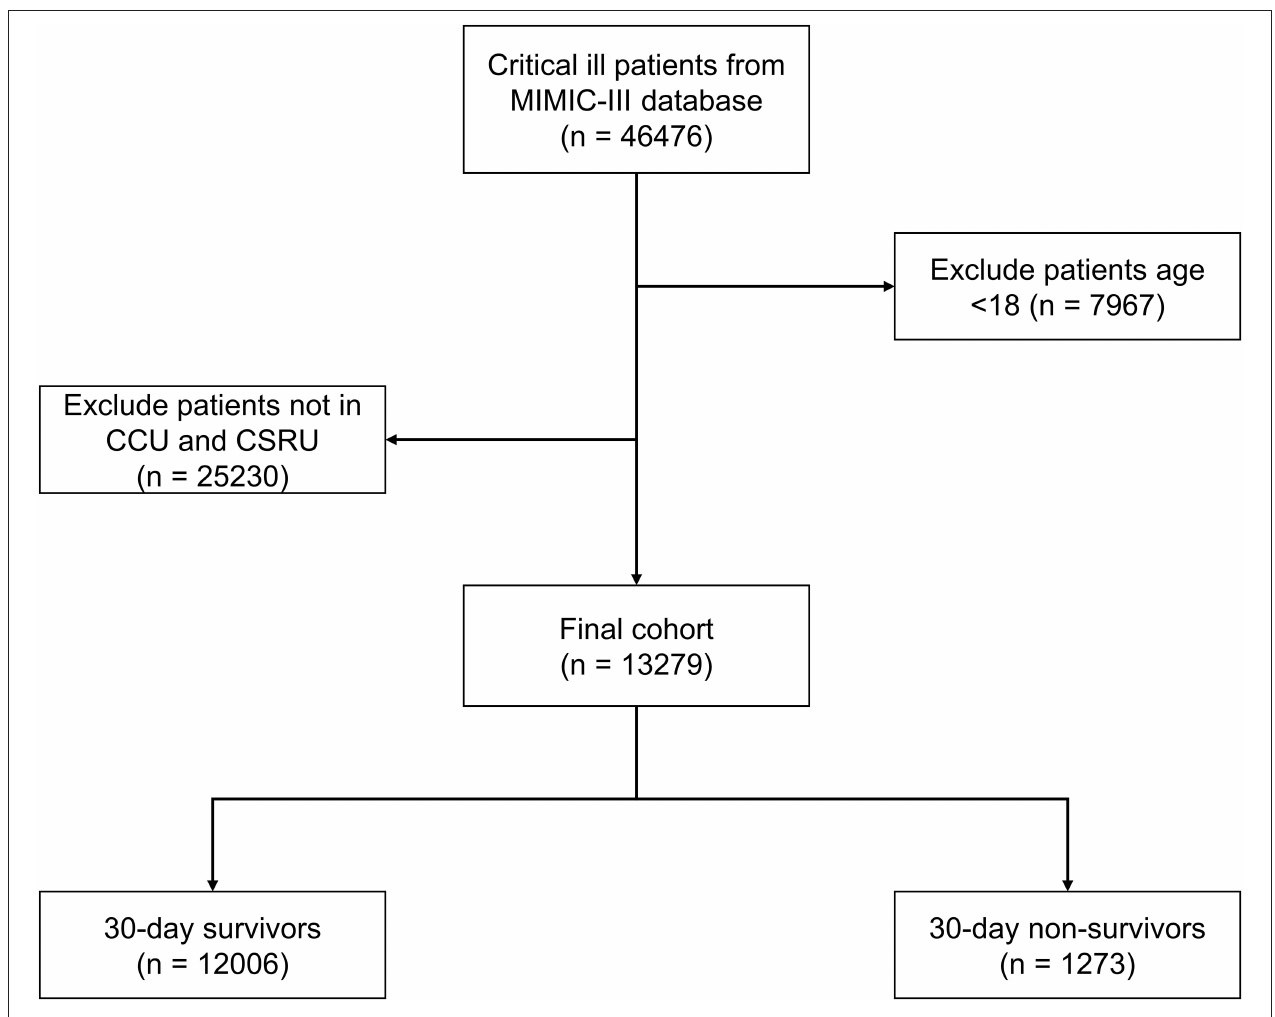
FIGURE 1 | Flow chart of the study